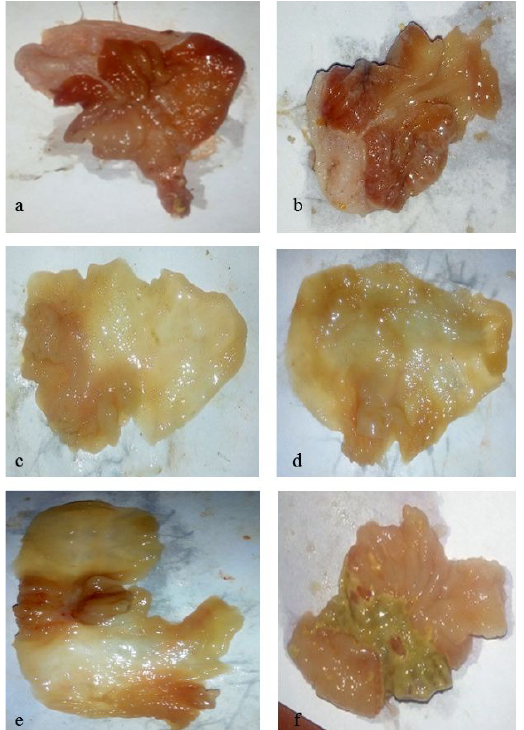
Fig. 1. Morphological visualization of the gastric mucosa of rats: a) uninduced and untreated; b) 60 mg kg -1 cimetidine treated; c) 35 mg kg -1 extract treated; d) 70 mg kg -1 extract treated; e) 140 mg kg -1 extract treated; f) induced &